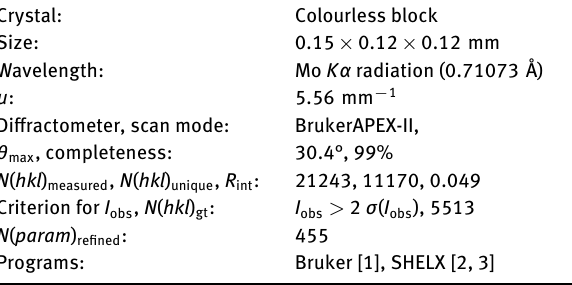
Table 1: Data collection and